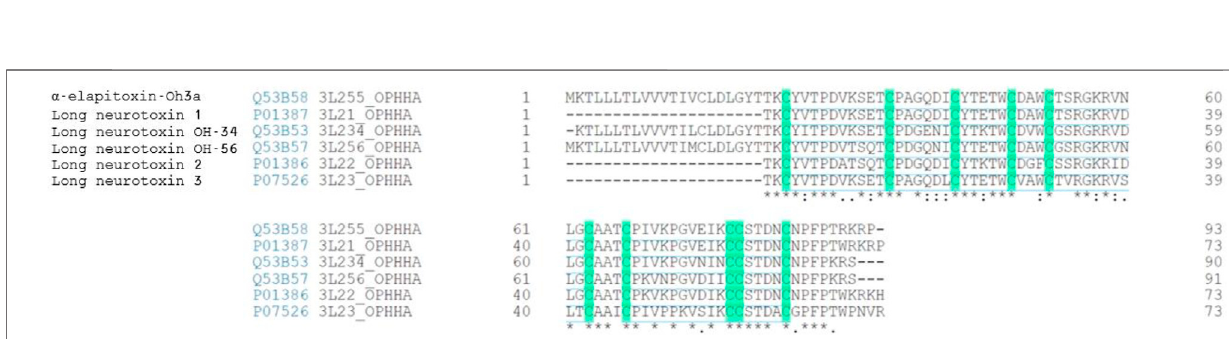
long neurotoxin 3, long neurotoxin OH-34, long neurotoxin OH-56 isolated from the venom of O. hannah ( Figure 4 ).